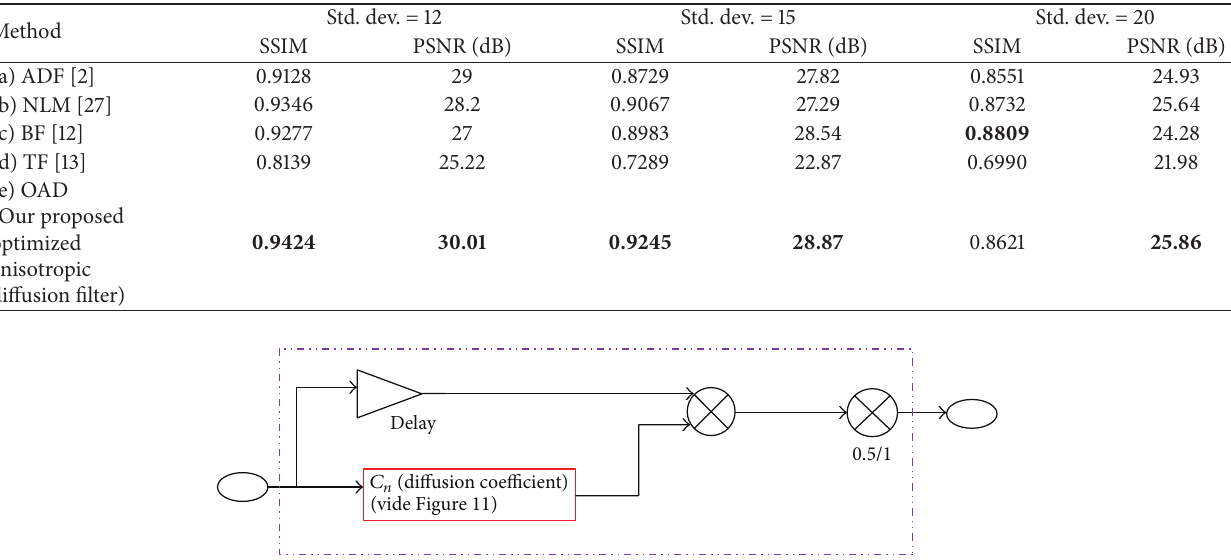
Figure 10: This hardware module multiplies the diffusion coefficient 𝐶 𝑛 with the pixel gradient ∇𝐼 to produce 𝐶 𝑛 ∇𝐼 .